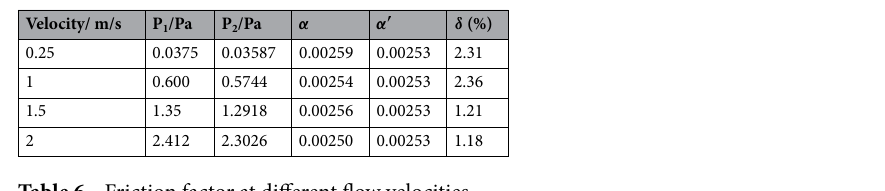
Table 6. Friction factor at different flow